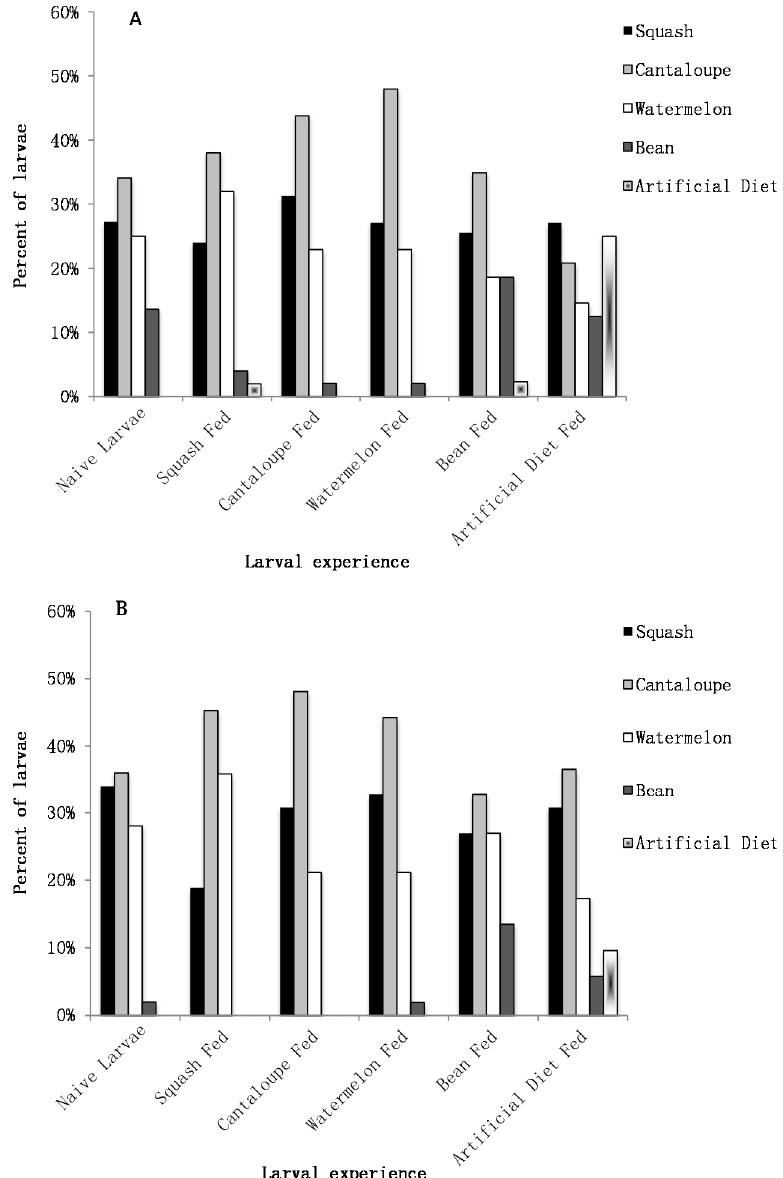
Figure 2. Percent of larvae ( A ) orienting to food sources after 1 h and ( B ) settling on food sources after 24 h following different feeding experiences.